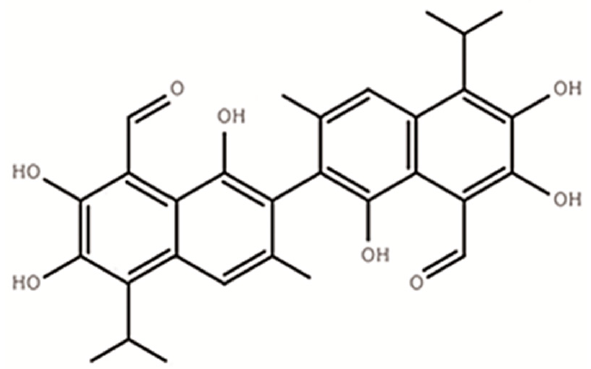
Figure 1. The structure of free gossypol (C 30 H 30 O 8 ).